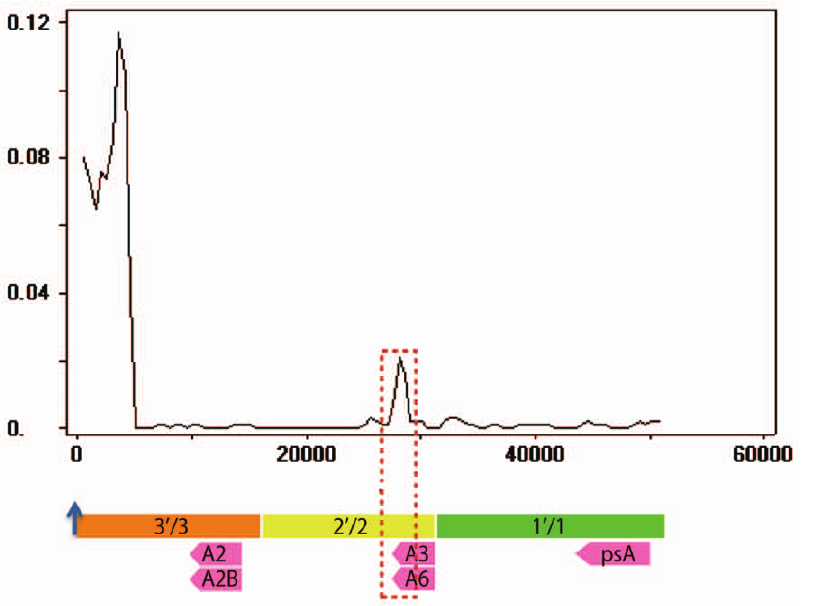
Figure 7. Window analysis of nucleotide divergence between a pair of palindrome arms in the human genome. The window size is 500 bp with no overlap between adjacent windows. Colored rectangles at the bottom of the figure indicate the duplicated unit including the MAGE genes (light pink arrows). The ordinate represents nucleotide divergence ( d ) and the abscissa represents position (in bp) relative to the center of the loop (position zero, blue arrow). The area surrounding a red dotted line indicate the high diverged region in MAGE-A3 and MAGE-A6 .